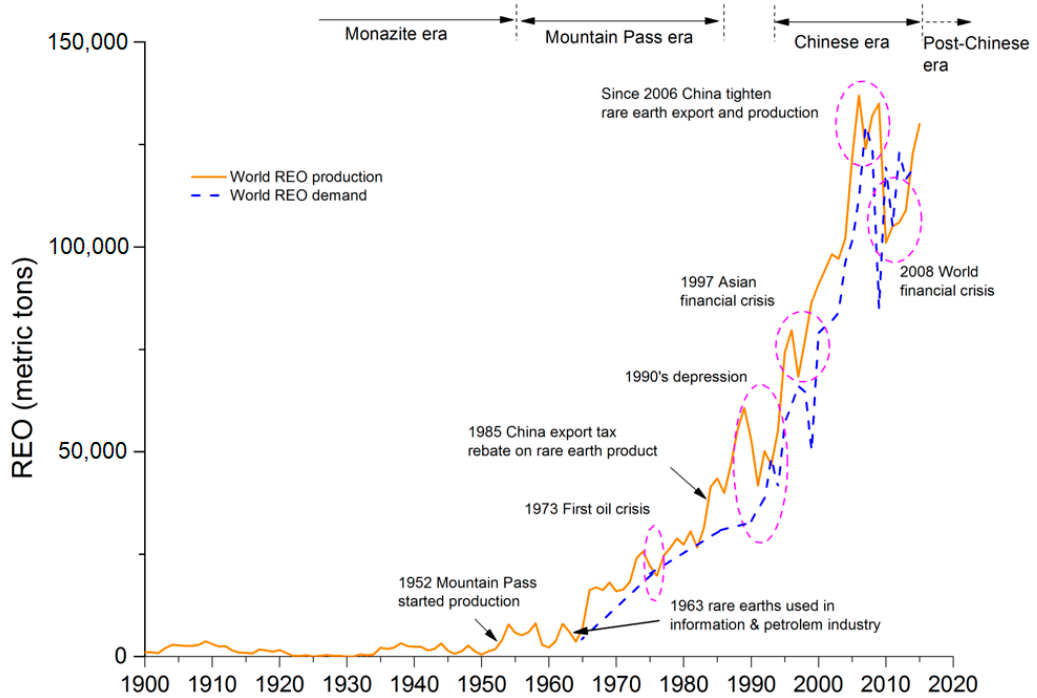
Figure 1. Global rare earth production and demand, the data obtained from [13–16].